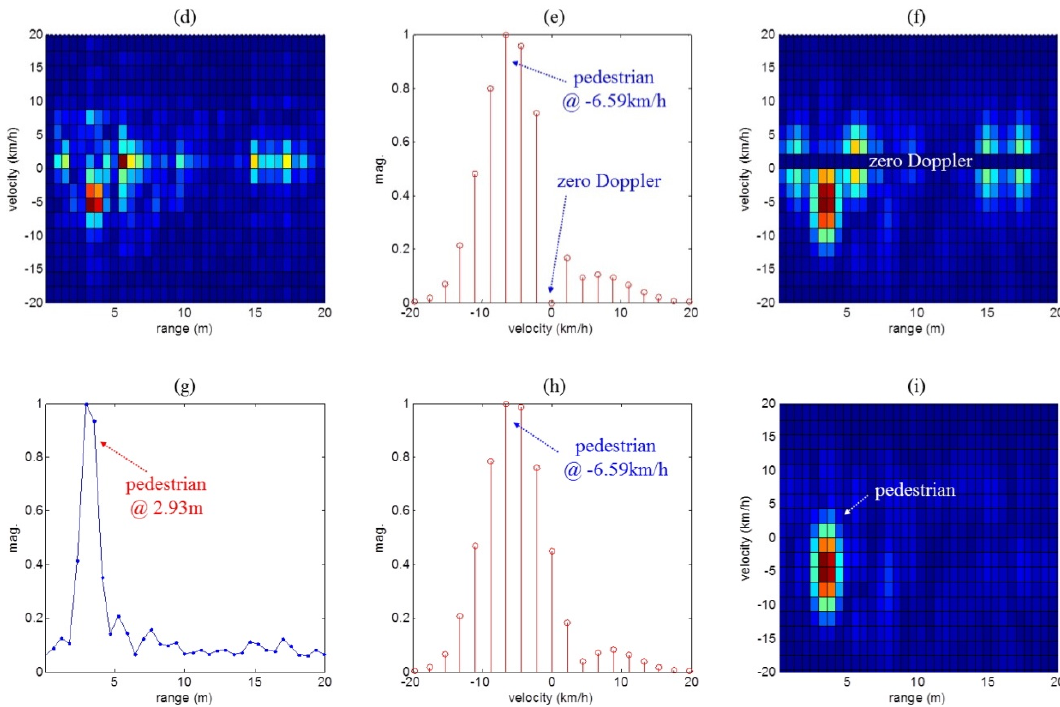
Figure 8. Measurement results obtained using the conventional method and the proposed detection method for scenario (i). Here, ( a – c ) present the results of the typical method using windowing; ( d ) indicates the results of the typical method without windowing; ( e , f ) show the results of removing the zero Doppler components in the typical method; and ( g – i ) are the results of the proposed method.